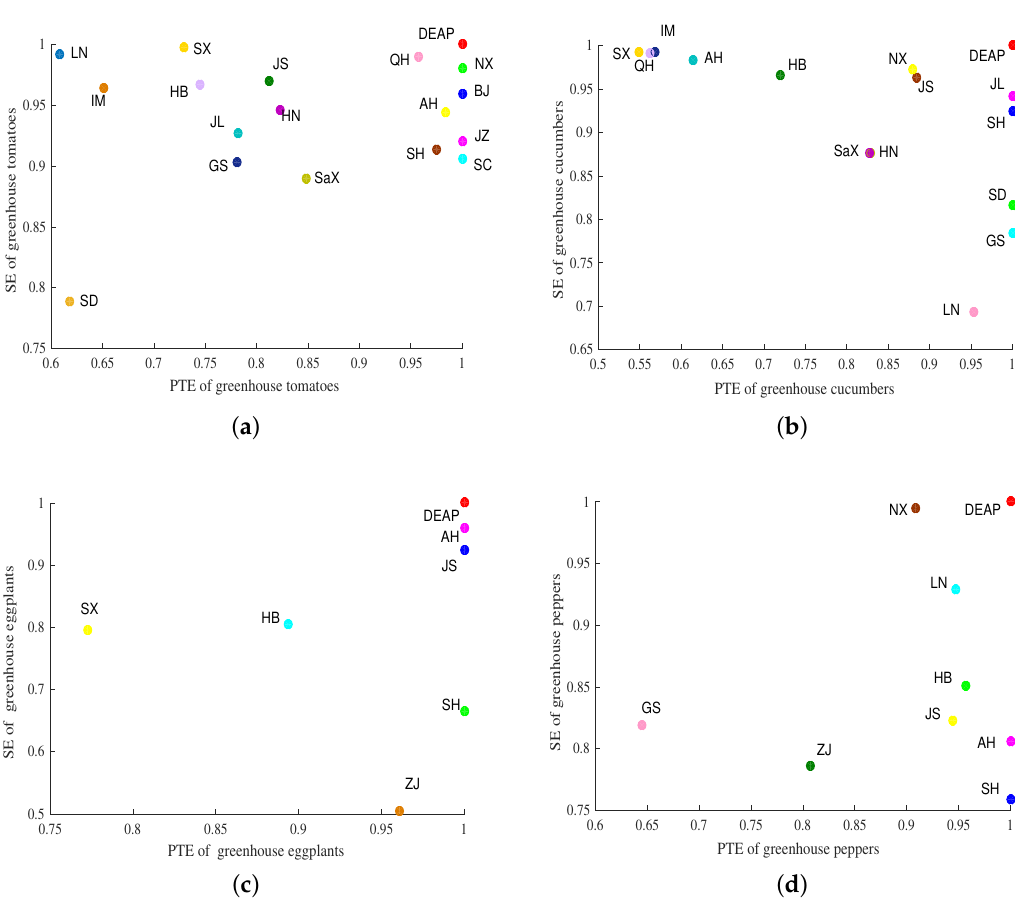
Figure 2. Efficiency distribution map of greenhouse tomatoes ( a ), greenhouse cucumbers ( b ), greenhouse eggplants ( c ) and greenhouse peppers ( d